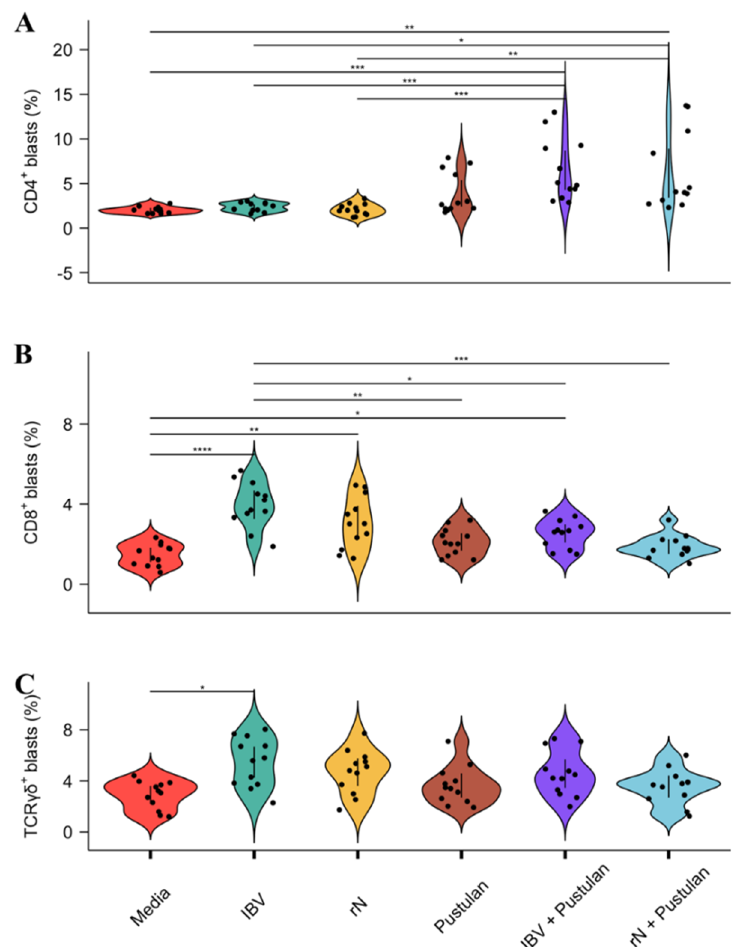
Figure 4. Blast transformation of the CD4 + ( A ), CD8 + ( B ), and TCRγδ + ( C ) T cells induced by the pustulan-adjuvanted antigen. PBMCs isolated from the heparin-stabilised blood of IBV-vaccinated MHC-matched chickens ( n = 6) were seeded in flat-bottom 96-well plates (1 × 10 6 cells/well) and treated for 72 h with RPMI-1640 (media), UV-inactivated IBV (0.15 dose/well), rN (20 µg/mL), pustulan (5 µg/mL), UV-inactivated IBV (0.15 dose/well) + pustulan (5 µg/mL), or rN (20 µg/mL) + pustulan (5 µg/mL). Blast transformations of the CD4 + , CD8 + , and TCRγδ + T cells were analysed by flow cytometry. Results are presented as violin plots with 95% confidence intervals showing the individual blast % values plotted of the technical replicates ( n = 2/treatment) from the biological replicates (n = 6/treatment). The data were log-transformed and a two-tailed Student’s t -test with Bonferroni multiple comparison correction was employed. A p value ≤ 0.05 was considered statically significant and differences between the treatments are indicated by bars. Significance level is indicated by asterisks * p ≤ 0.05, ** p ≤ 0.01, *** p ≤ 0.001, **** p ≤ 0.0001. UV-inactivated IBV induced a significantly different CD8 + blast percentage compared to the media (2.7× increase, p = 0.00002) (Figure 4B). Similarly, rN induced a significantly different CD8 + blast percentage compared to the media (2.1× increase, p = 0. 008). Moreover, UV-inactivated IBV induced a significantly different CD8 + blast percentage compared to pustulan (1.9× increase, p = 0.001), pustulan-adjuvanted UV-inactivated IBV (1.6× increase, p = 0.02), and the pustulan-adjuvanted rN (2.1× increase p = 0.00009). Only the UV-inactivated IBV induced a significantly different TCRγδ+ blast percentage compared to the media (1.9× increase, p = 0.015) (Figure 4C).